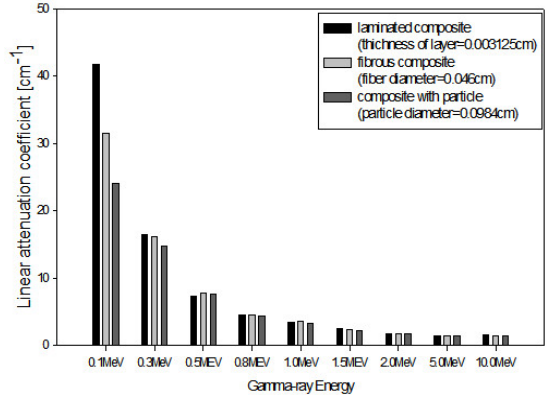
Figure 18. Linear attenuation coefficient of PE/lead composites according to composite structure.